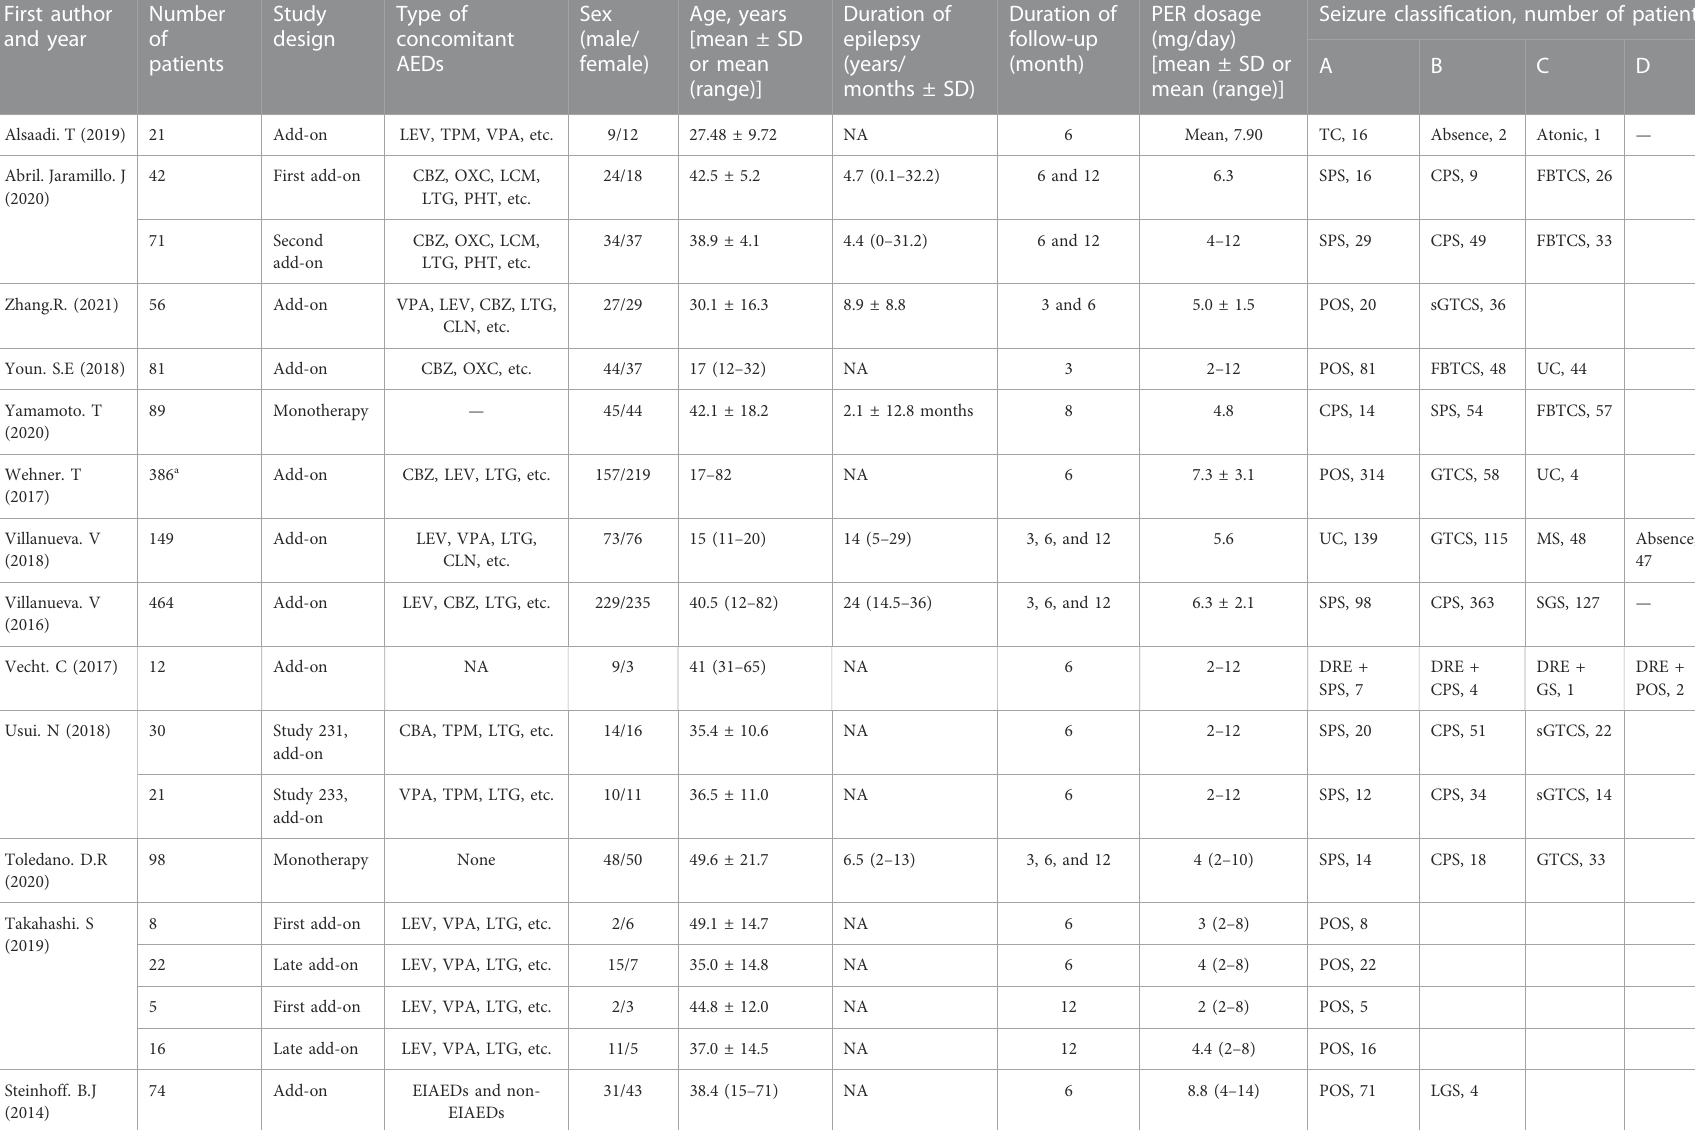
TABLE 1 Characteristics of the observational studies included in this